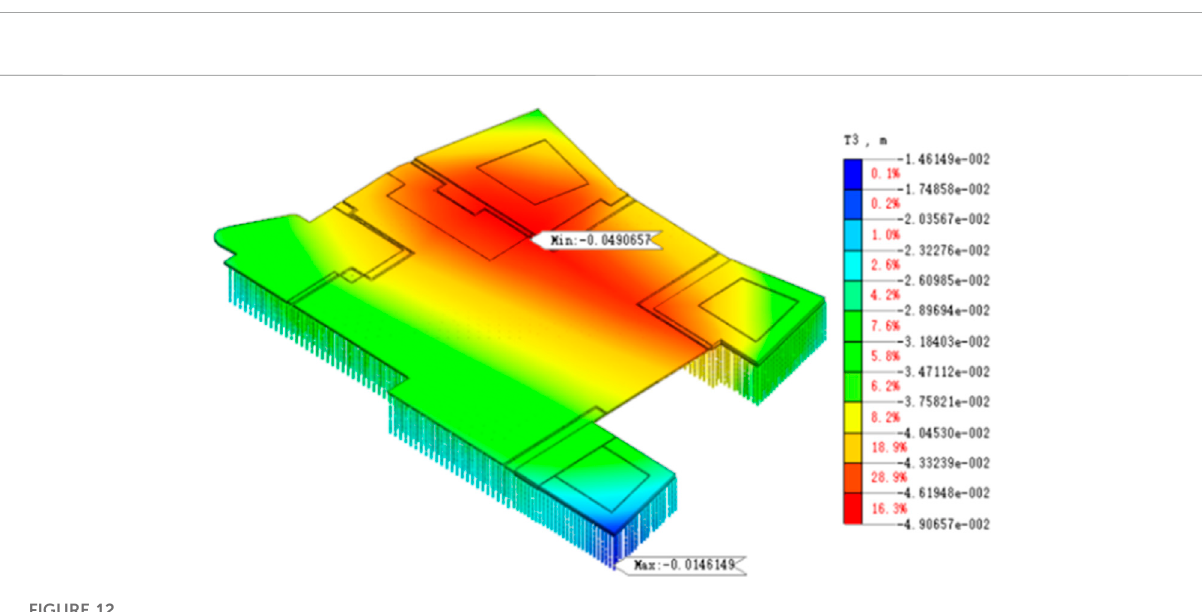
FIGURE 11 Differential settlement of the two sides of the late poured band. (A) Late poured band 1 (B) Late poured band 2. (C) Late poured band 3.